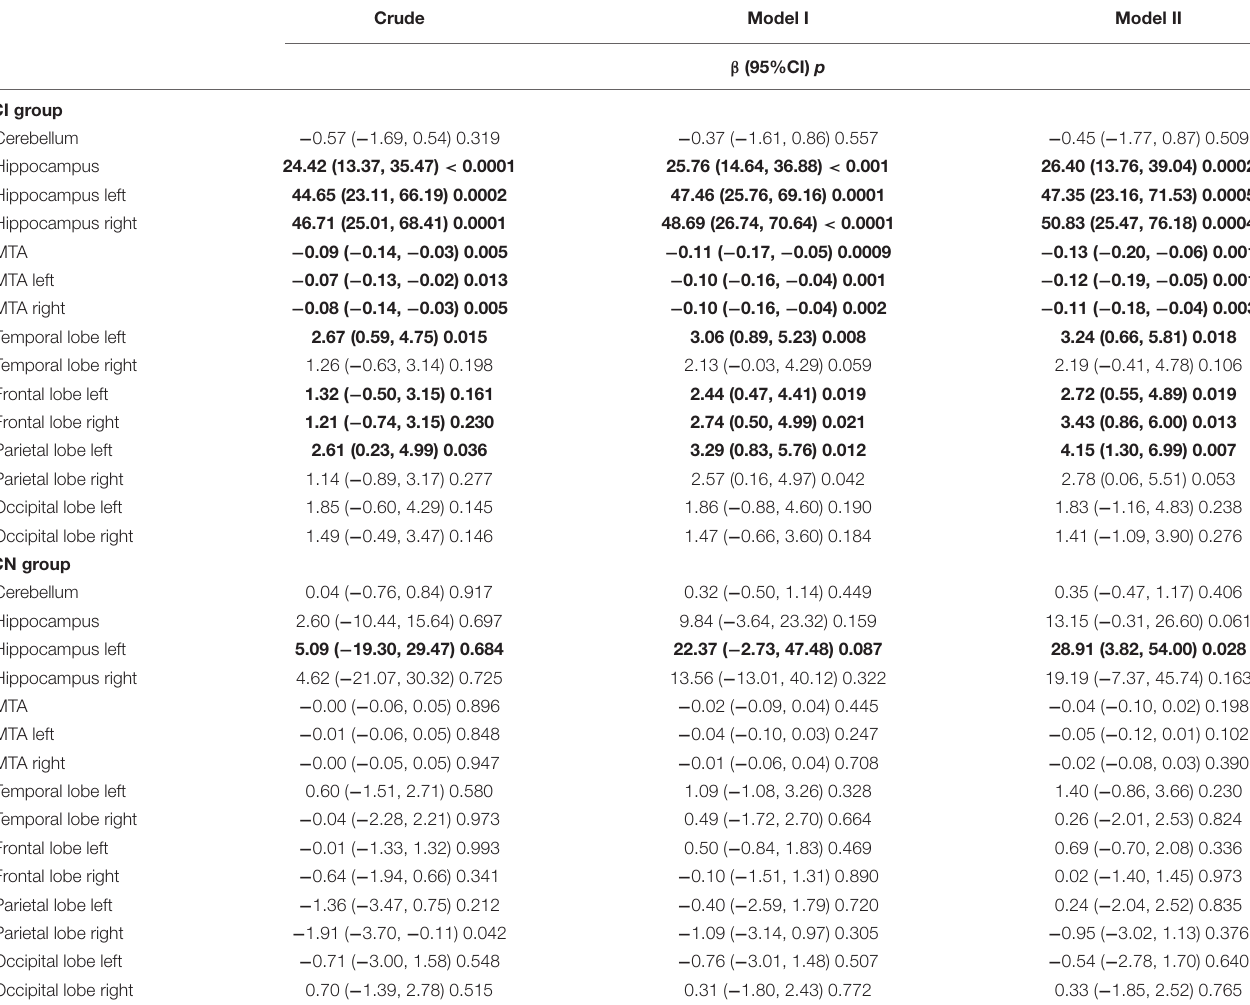
TABLE 3 | Association between brain volumes and SDM in different groups